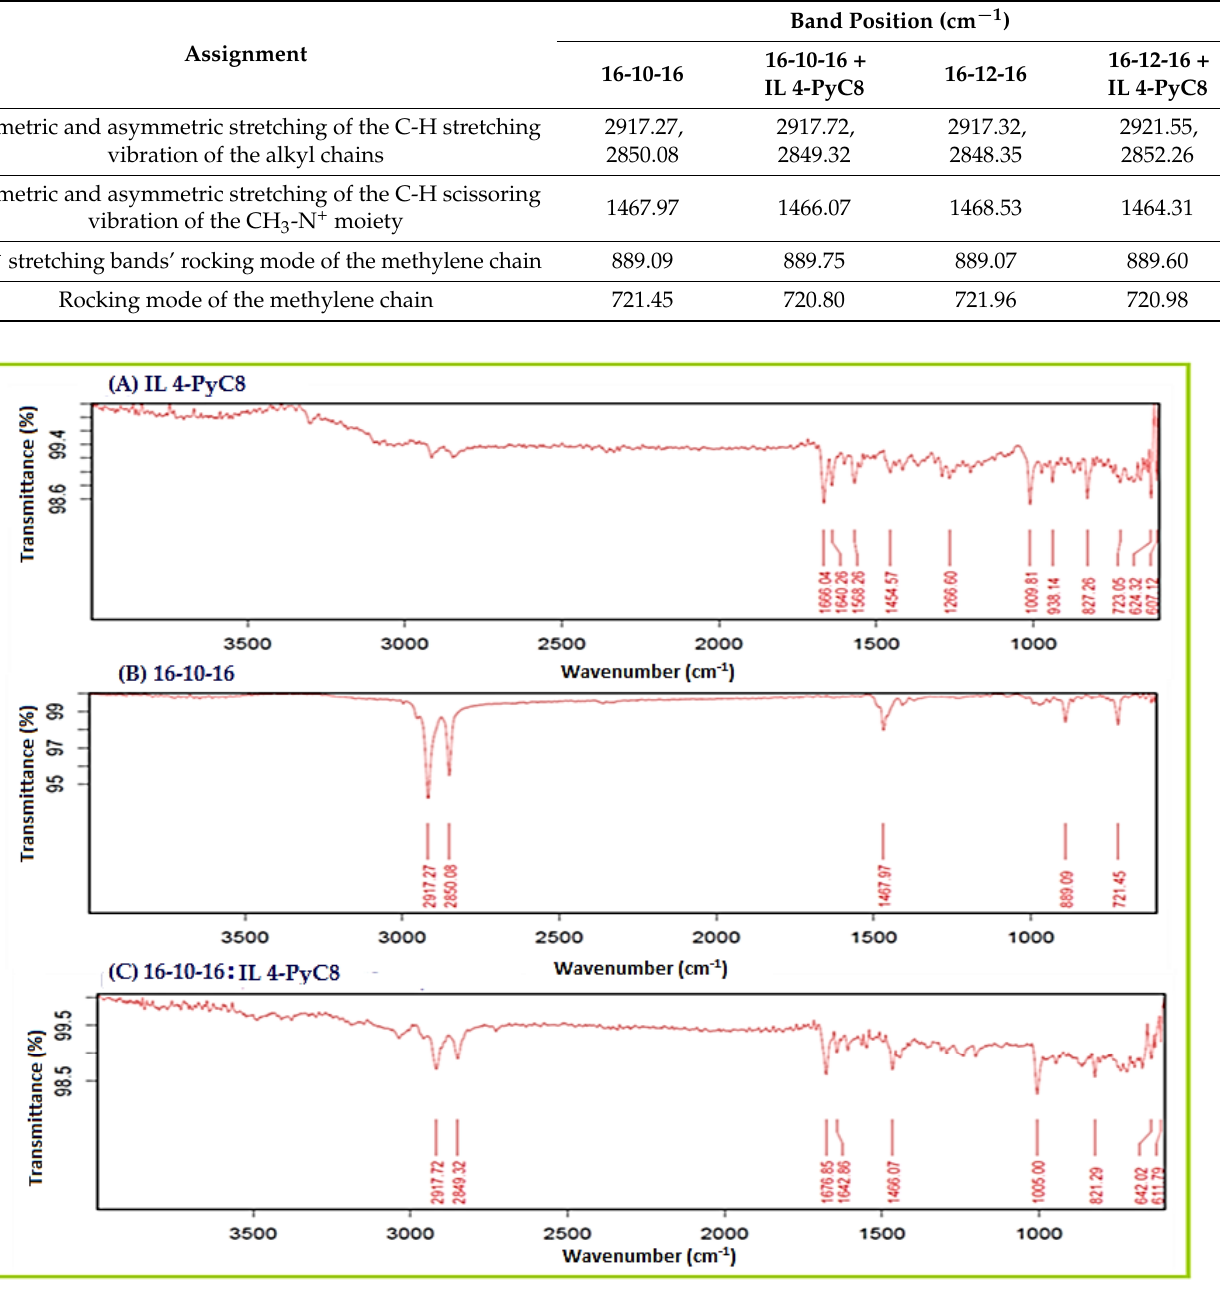
Figure 5. FTIR spectra of the ( A ) IL 4-PyC8, ( B ) 16-10-16 and ( C ) 16-10-16:IL